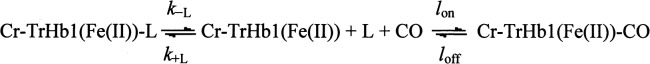
Scheme of the CO binding reaction.